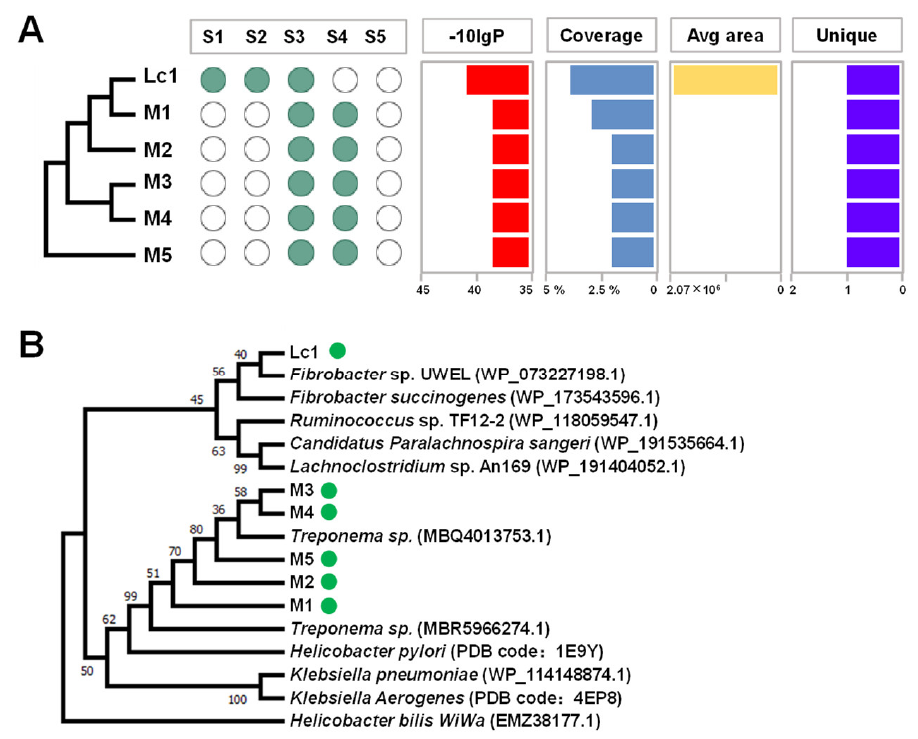
Figure 3. Discovery of rumen microbial urease by targeting activity-based screening. ( A ) Metapro- teomic analysis of Fraction 9 with the highest urease activity. S1–S5 represents sample1–sample5. Different ureases were discovered in different samples (green dot) with different scores. − 10 lgP: the PEAKS protein score. Coverage: the percentage of the peptide mapped to the identified protein. Avg area: average abundance of identified proteins. A zero in Avg area column means there is no feature detected but there is identification. Unique: unique peptide. ( B ) Phylogenetic trees of identified rumen microbial ureases. Numbers at nodes represent bootstrap support values. The accession numbers of protein in the NCBI GenBank database are in parentheses.